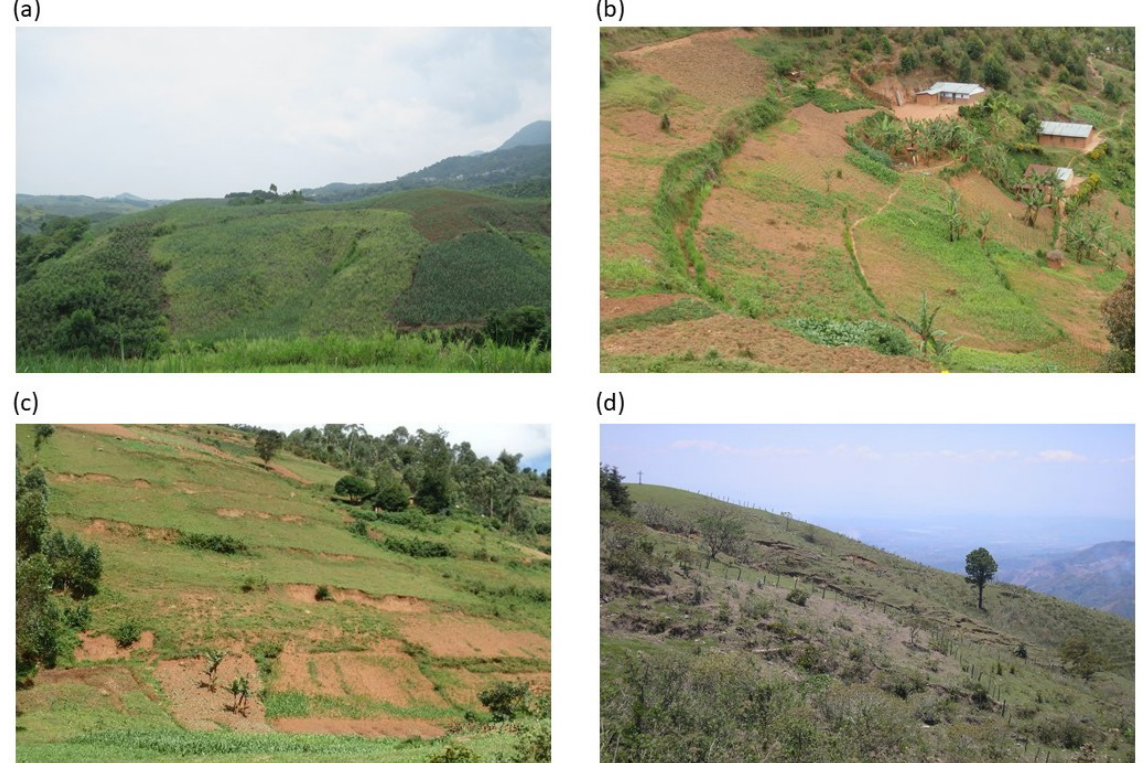
Figure 8. (a) Sugar cane cultivation on steep slopes in southern China (Nanning, Guangxi Zhuang Autonomous Region). The steepest slopes are already abandoned and reforested by eucalyptus trees. (b) Maize cultivation on strongly eroded slopes (30%–60%) in south-west Uganda (Kigwa, Kabale District). (c) Abandoned fields and maize cultivation on a steep slope (30%–60%) in south-west Uganda (Kigwa, Kabale District). (d) Degraded and abandoned maize fields on steep slopes (20%–60%) in northern El Salvador (San Ignacio, Chalatenango Department). The photos and additional examples are provided in Figs.